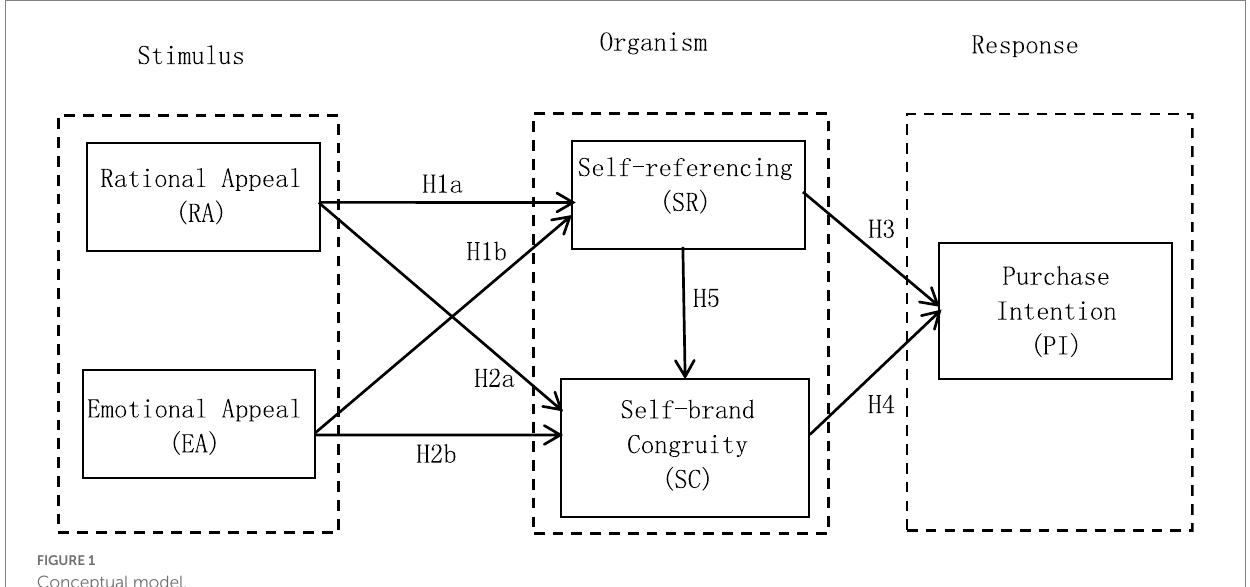
FIGURE 1 Conceptual